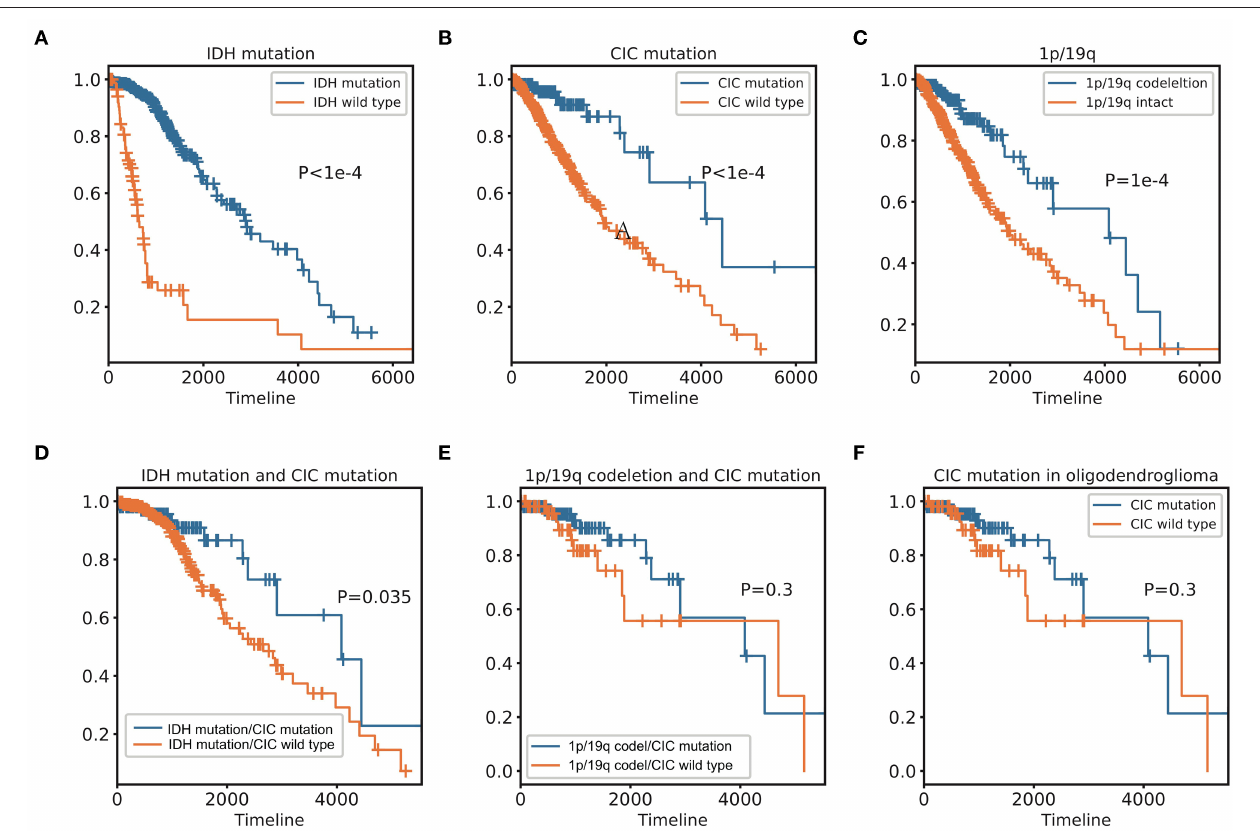
FIGURE 5 | Kaplan Meier curve and Log-Rank test of IDH, 1p/19q, and CIC. (A) IDH mutation Kaplan-Meier curve shows that patients with IDH mutation have a significantly better prognosis than IDH wild type. (B) CIC mutation Kaplan-Meier curve shows that patients with CIC mutation have significantly longer OS than those whose CIC is wild type. (C) Patients with 1p/19q codeletion have significantly longer OS than those without 1p/19q codeletion. (D) Patients with IDH and CIC mutation have longer OS than patients have IDH mutation only. (E) There is no significant difference in OS between CIC mutation and CIC wild-type of patients with 1p/19q codeletion. (F) 2016 classification Oligodendroglioma. In the Log-Rank test, there is no significant survival difference between patients with and without CIC mutation.